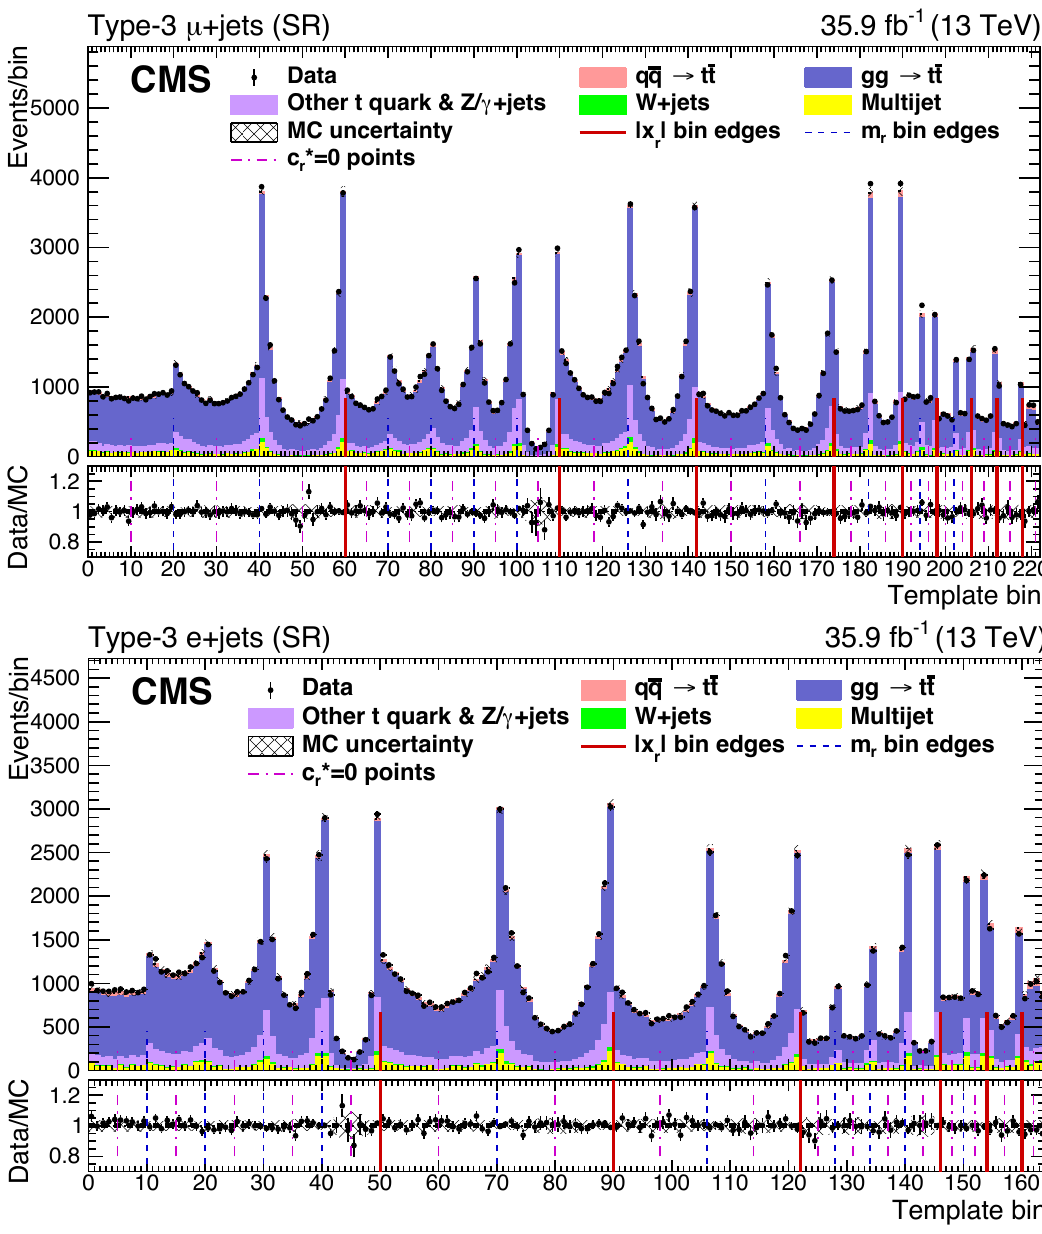
Figure 10 . Comparisons of (cid:12)tted data and MC expectations as a function of template bin number for the A (1) parameter extraction. The plots show events in the type-3 m +jets (upper) and e+jets FB (lower) channels, all summed over lepton charge. The MC uncertainty pictured in the hatched bands represents the total (statistical and systematic) uncertainty. The vertical solid, dashed, and dot- dashed lines indicate the edges of the bins in x and m and the midpoints of the c (cid:3) distributions, r r respectively, corresponding to the binning schemes listed in tables 7 and 8 in appendix B.